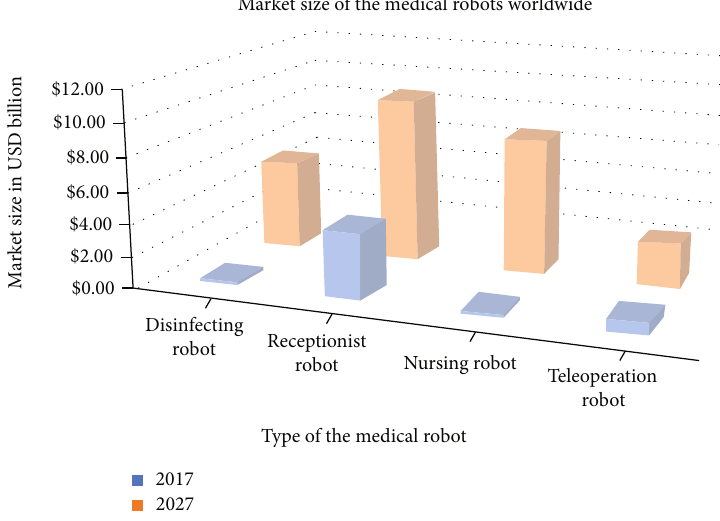
Figure 3: Market size of the various medical robots used